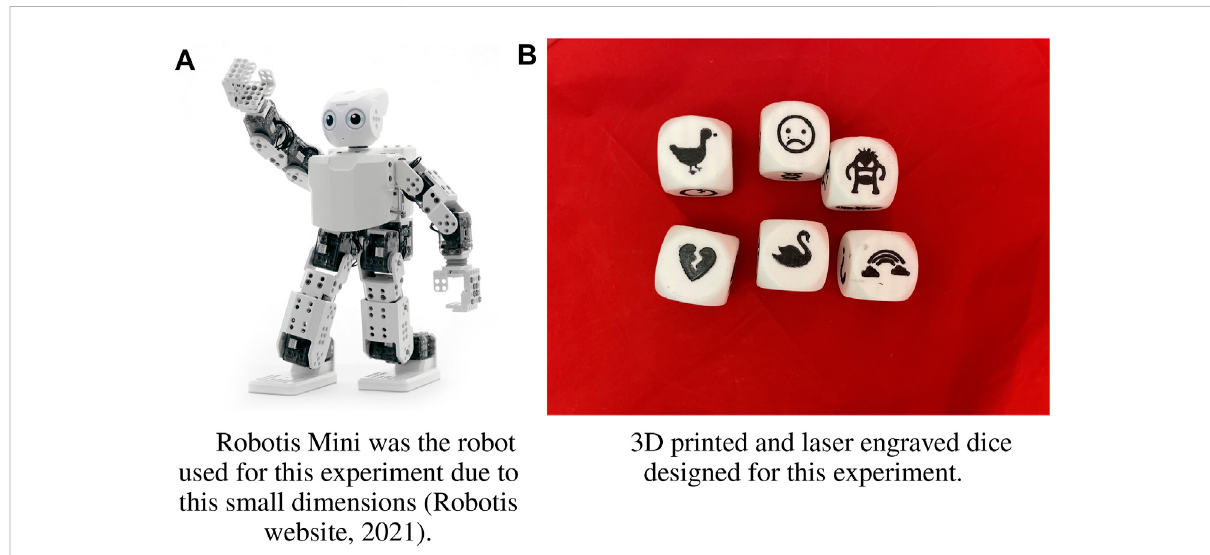
FIGURE 1 Robot and Story Cubes used for this experiment. (A) Robot mini was the robot used for this experiment due to this small dimensions (Robotis website, 2021) (B) 3D printed and laser engraved dice designed for this